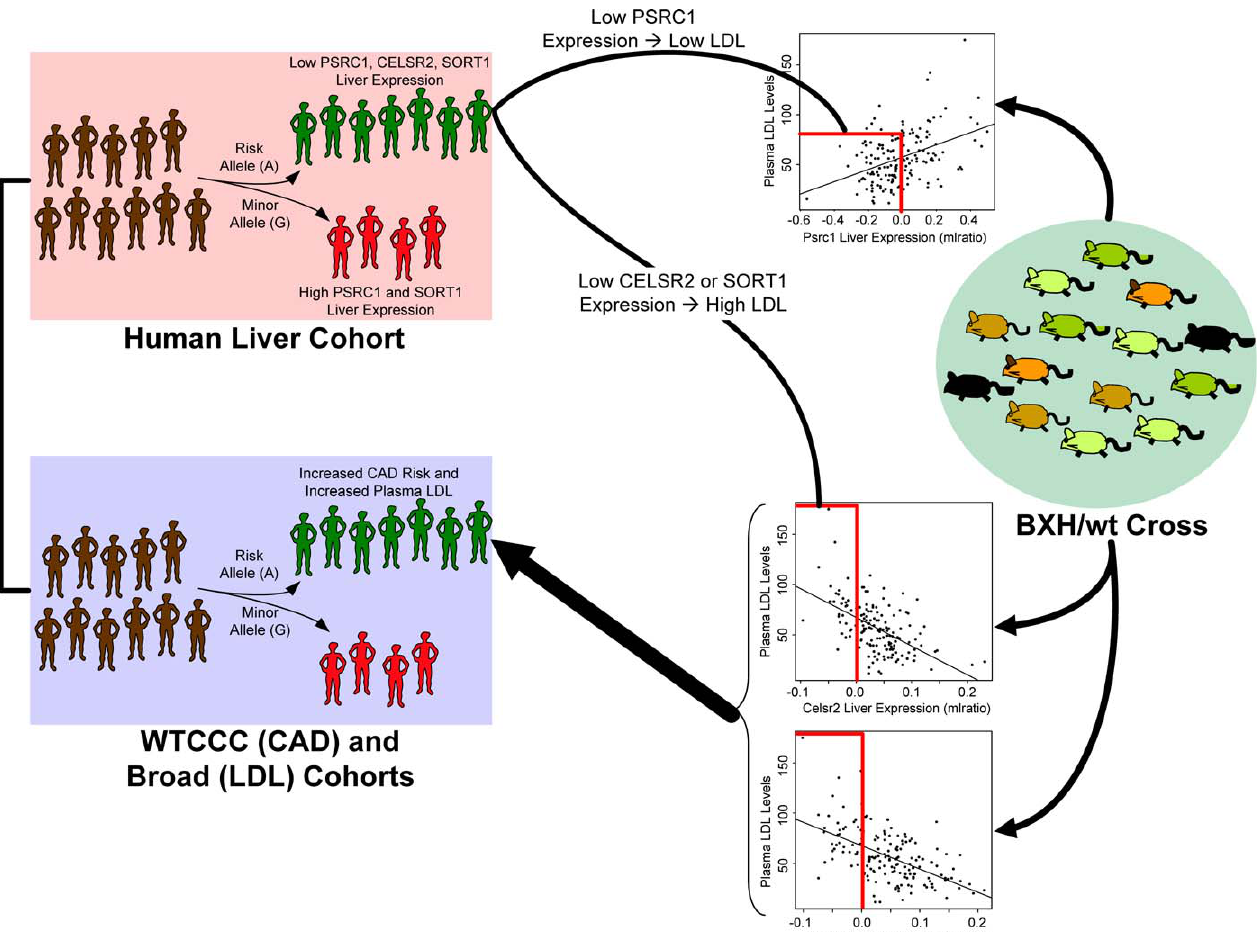
Figure 2. PSRC1 , CELSR2 , and SORT1 Liver Expression Is Associated with a CAD Risk Allele and Plasma LDL Cholesterol